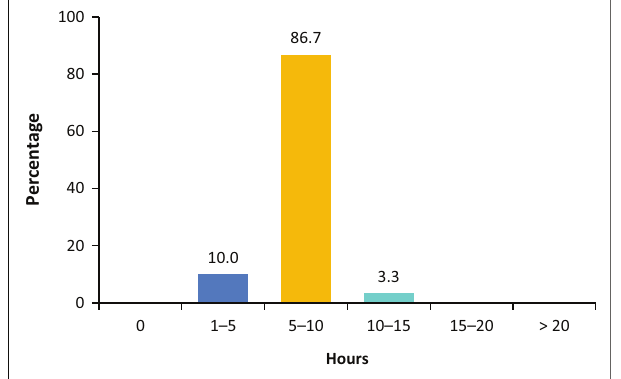
FIGURE 6: Respondents’ response rate by university affiliation.